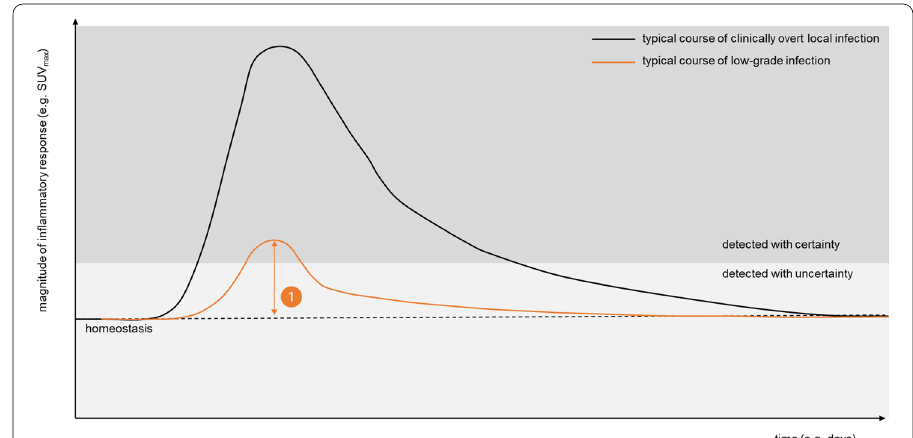
Fig. 1 Artificial intelligence to improve detection. A graphical illustration of the typical dynamics of an immune response upon a trigger, with rapid increase, associated with increased glycolysis in effector cells which can be measured by [ 18 F]FDG PET and expressed as maximum or mean standardized uptake values (SUVmax/mean). As soon as the causative trigger is cleared, inflammatory responses also include repair processes to gradually return to a state of tissue